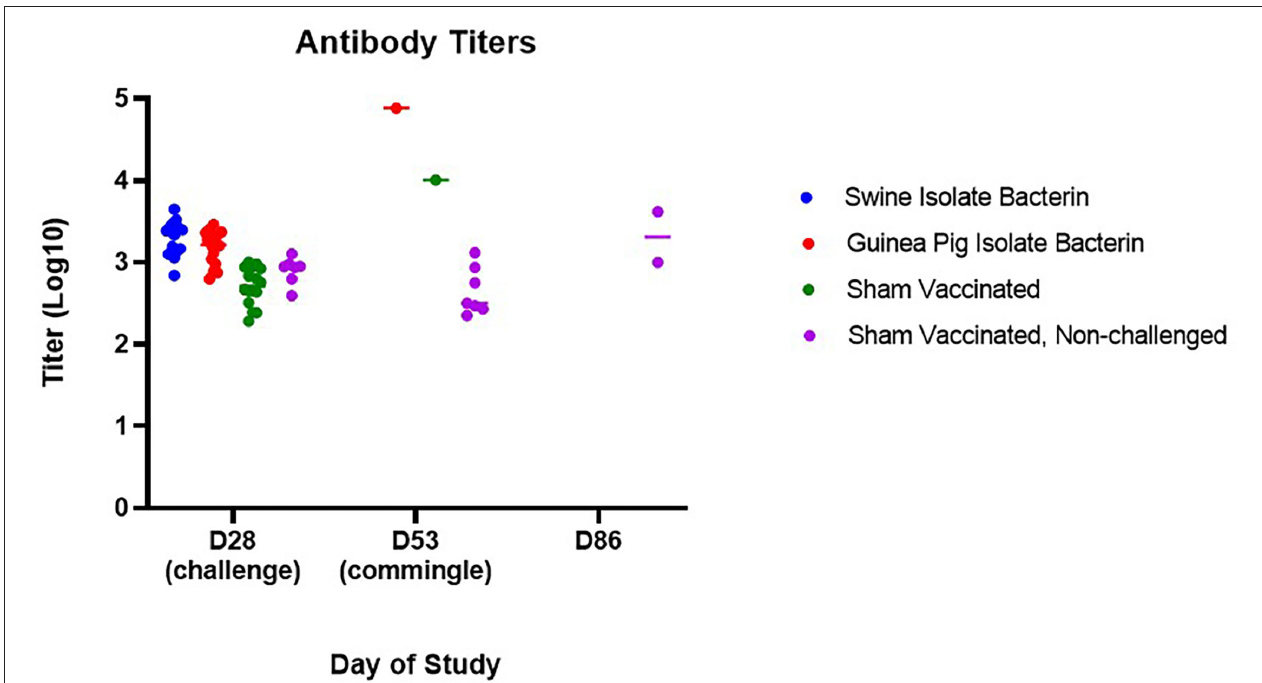
FIGURE 4 | Serum antibody evaluation following challenge and commingling. Antibody titers for surviving animals were significantly higher than non-challenged animals 25 days post-challenge (day 53) (guinea pig isolate bacterin, p = 0.0009; sham vaccinated, p = 0.0110). Following commingling, an increase in titer was observed in surviving animals ( p = 0.0177), although only one of the two surviving animals had a 4-fold increase in titer from D53 to